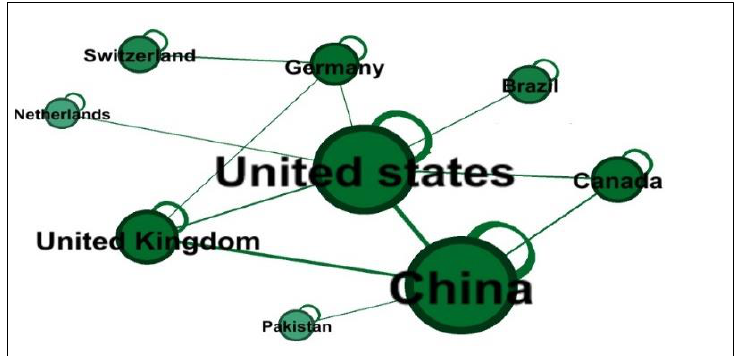
Figure 10. Countries that collaborated most frequently on CSE authorships. We used community detection to discover the countries that collaborated the most in the CSE co-authorship network. Countries in the same cluster were highly collaborative. Figure 11 shows the co-authorship clusters in the network. The largest clusters were the purple and green clusters. The purple cluster contained 20 countries, 3 of which were the most productive countries in CSE research (China, United States, and United Kingdom). The green cluster contained 12 countries, which were also highly collaborative, with Switzerland and Germany as the centers of this cluster.